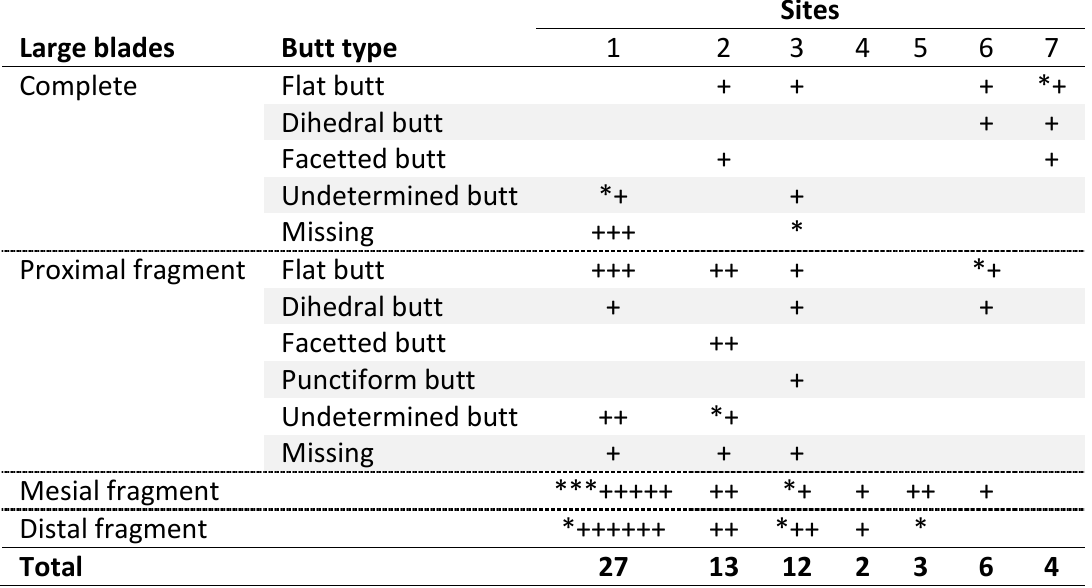
Table 2. Technological approach to large blades. Butt types. The asterisk (*) corresponds to